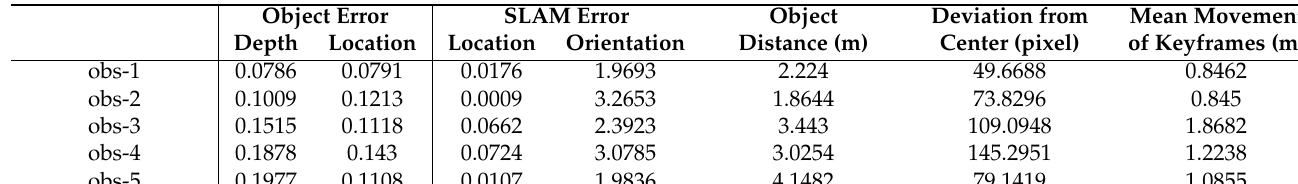
Table 6. The error statistics for multiple view object positioning.